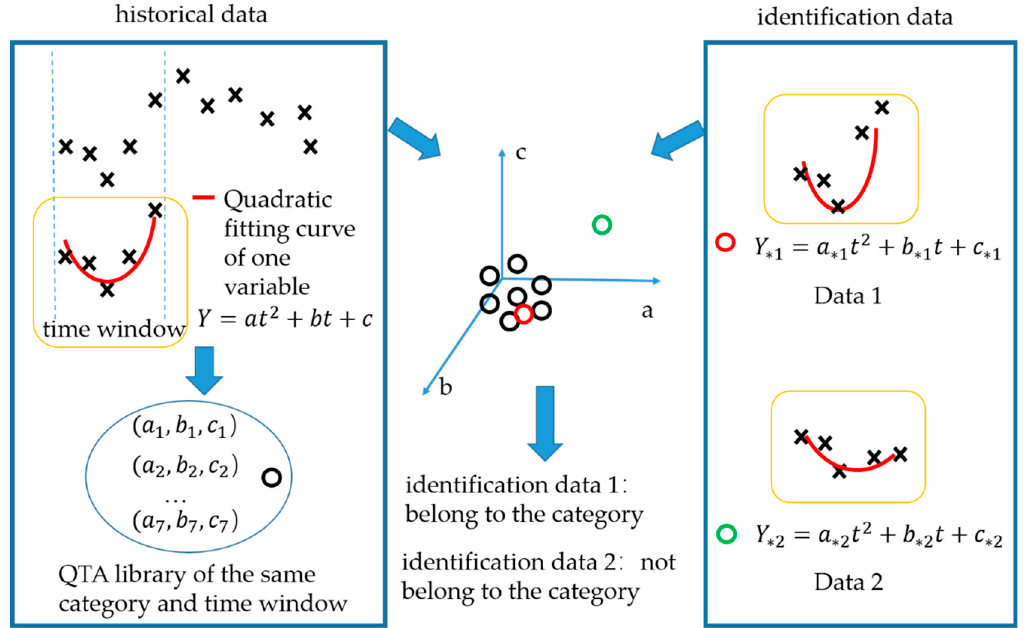
Figure 2. The basic principle of the proposed method.